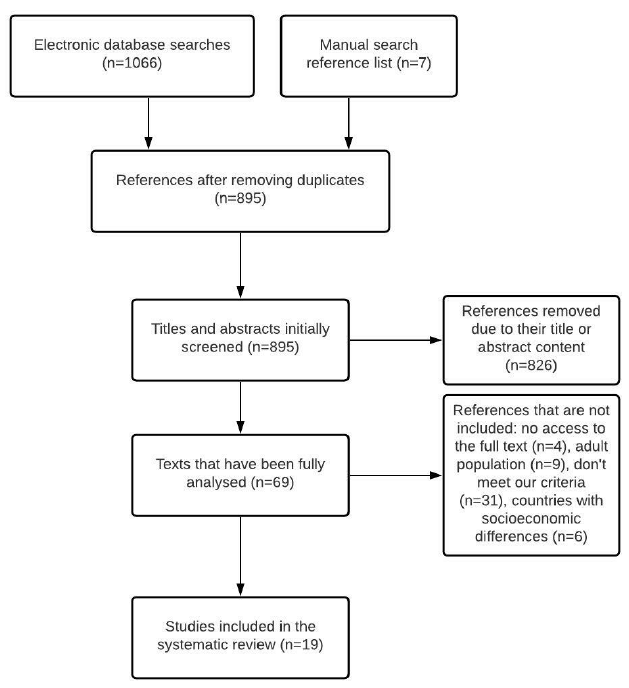
Figure 1. PRISMA flow